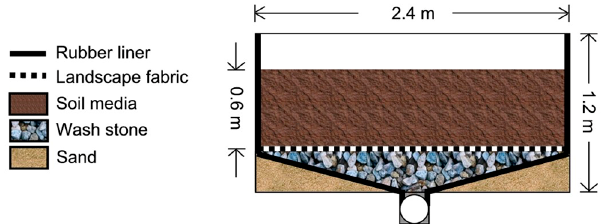
Figure 1. Diagram of mesocosm construction showing the dimensions of the wooden frame, interior rubber liner, soil media, landscape fabric over wash stone, and a supportive layer of sand shaped to direct drainage through a central pipe.